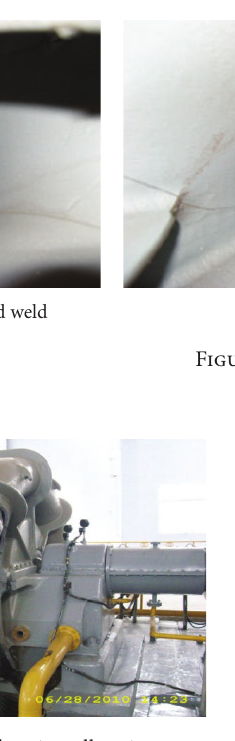
Figure 4: Typical failure impeller